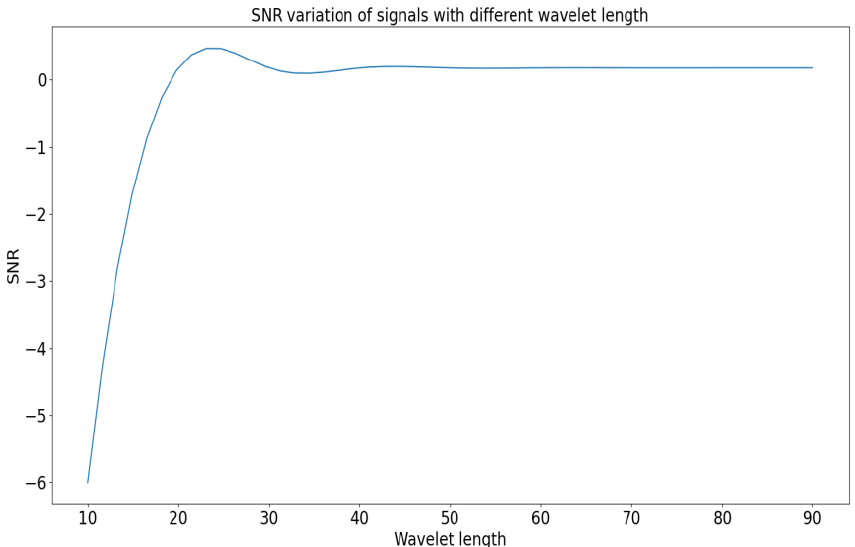
Figure 13. SNR variation of signals with different wavelet length.